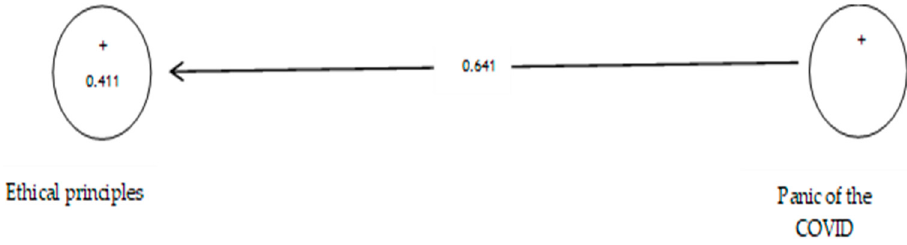
Figure 14. The sixth sub-hypothesis model includes factor load coefficients.